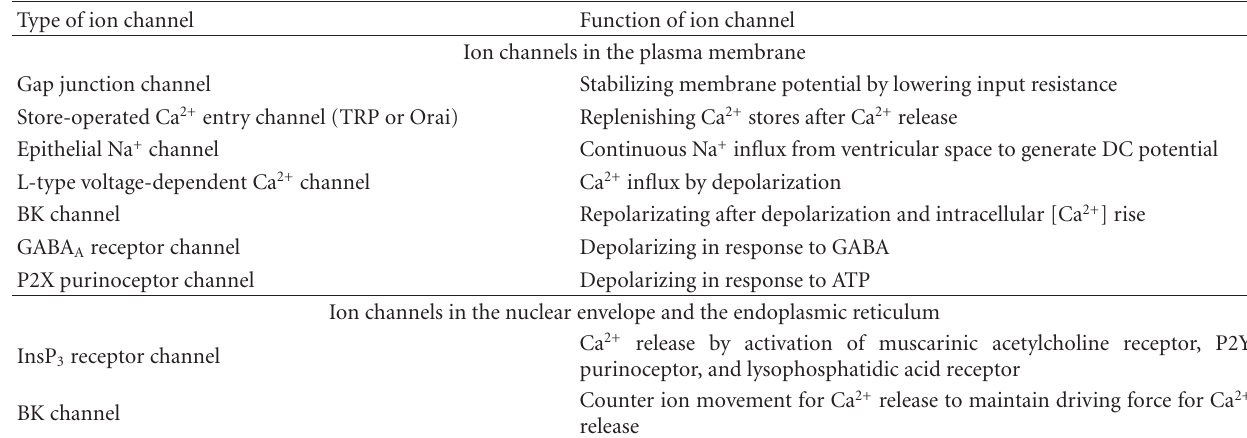
Table 1: Neuroepithelial-cell-ion channels and their